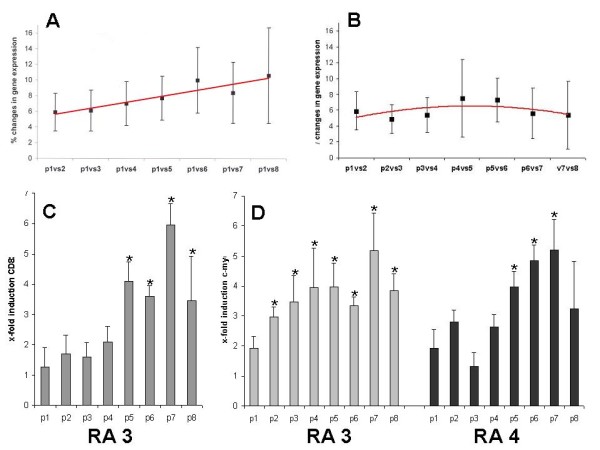
Changes in gene expression during passaging. (a) The changes in gene expression increase substantially during passaging of the cells in all fibroblast cultures. In addition, the variations and differences between expression pattern in the different rheumatoid arthritis synovial fibroblasts (RASF) cultures increase also in later passages (% changes of gene expression ± standard error of the mean). The regression line shows a clear increment in the course of the culture of the cells (red). (b) Changes in gene expression comparing higher passages instead of passage 1. (c) Verification of CD82 and c-myc regulation using real-time PCR. Passaging was performed in two parallel cultures for each fibroblast population. Real-time PCR was performed threefold (six measurements for each population, respectively).